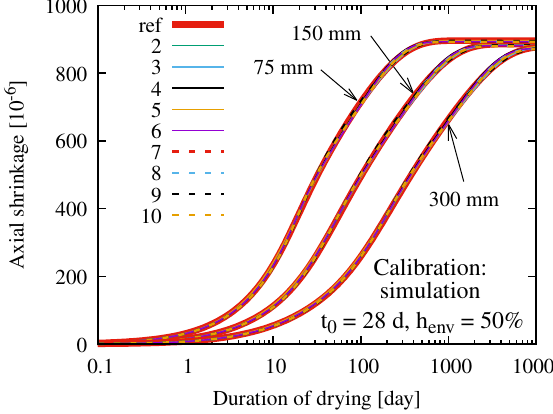
Figure 9. Best fits of (reference) axial shrinkage of 75 mm, 150 mm, and 300 mm thick slabs exposed to symmetric drying at h env = 50% ( t 0 = 28 days).